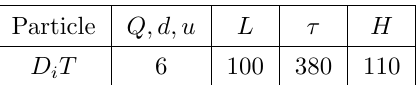
Table 8. Di(cid:11)usion constants for the transport equations as derived in ref. [78]. Particle (cid:14)m 2 =T 2